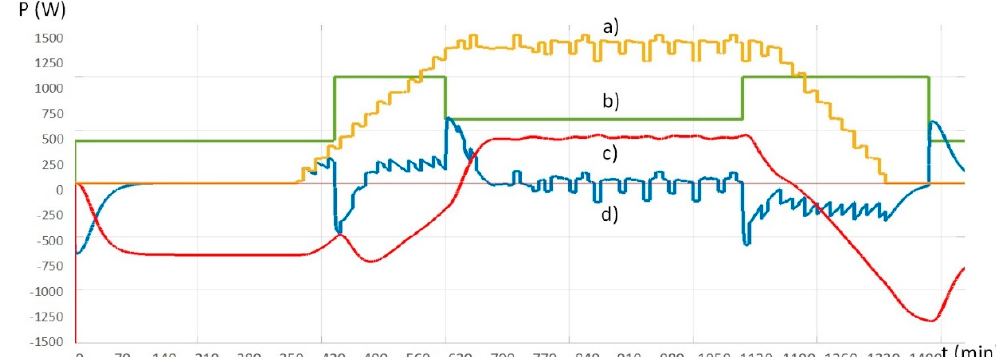
Figure 13. Simulation process for sunny day conditions. Storage system filter with damping ratio ζ = 0.25: ( a ) the PV plant production, ( b ) the power required by the consumer, ( c ) the battery storage power and ( d ) the supercapacitor power.